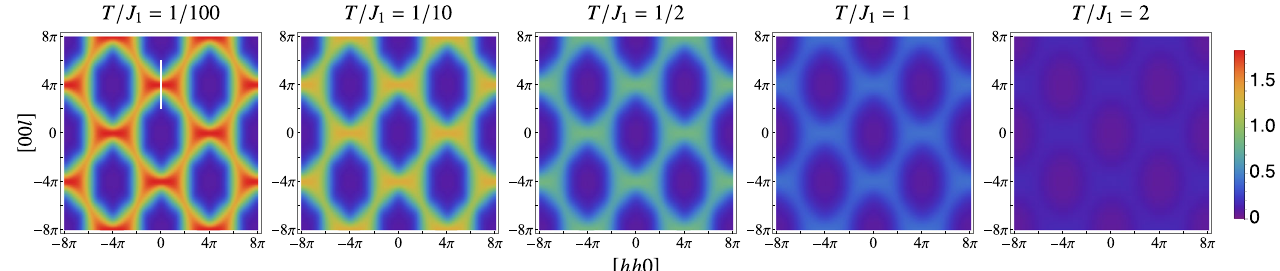
FIG. 6. The spin susceptibility profile (in units of 1 =J 1 ) in the ½ hhl (cid:2) plane at different temperatures for the S ¼ 1 = 2 isotropic nearest- neighbor Heisenberg antiferromagnet.